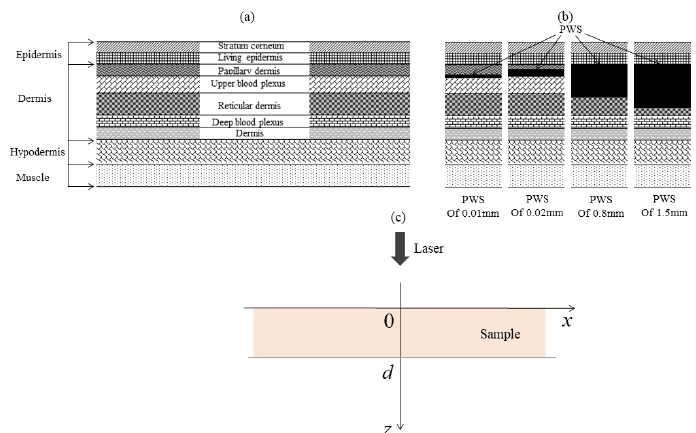
Figure 1. ( a ) Schematic of multilayered skin; ( b ) schematic of skin with different growth phases of a cancerous lesion; ( c ) theoretical model for photoacoustic detection of skin